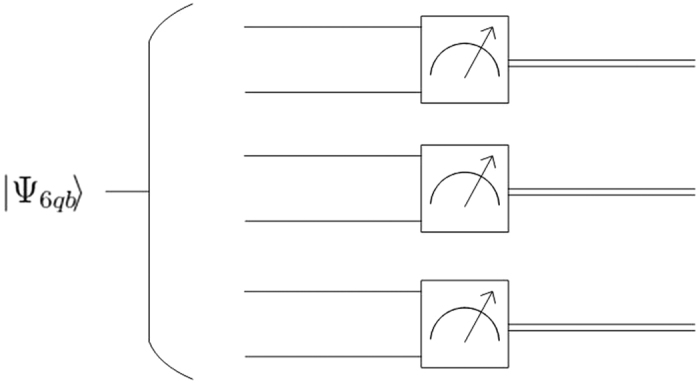
The circuit of a new QSS protocol based on |Ψ6qb〉.